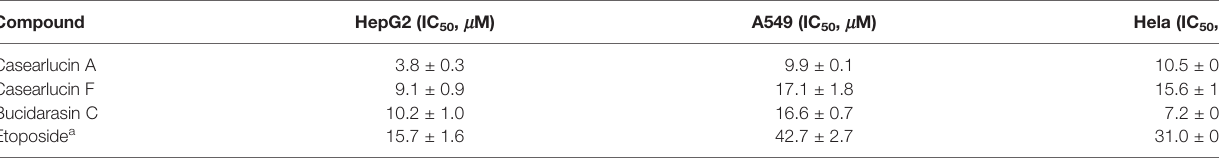
TABLE 1 | Cytotoxicities of three compounds against three human cancer cell lines.